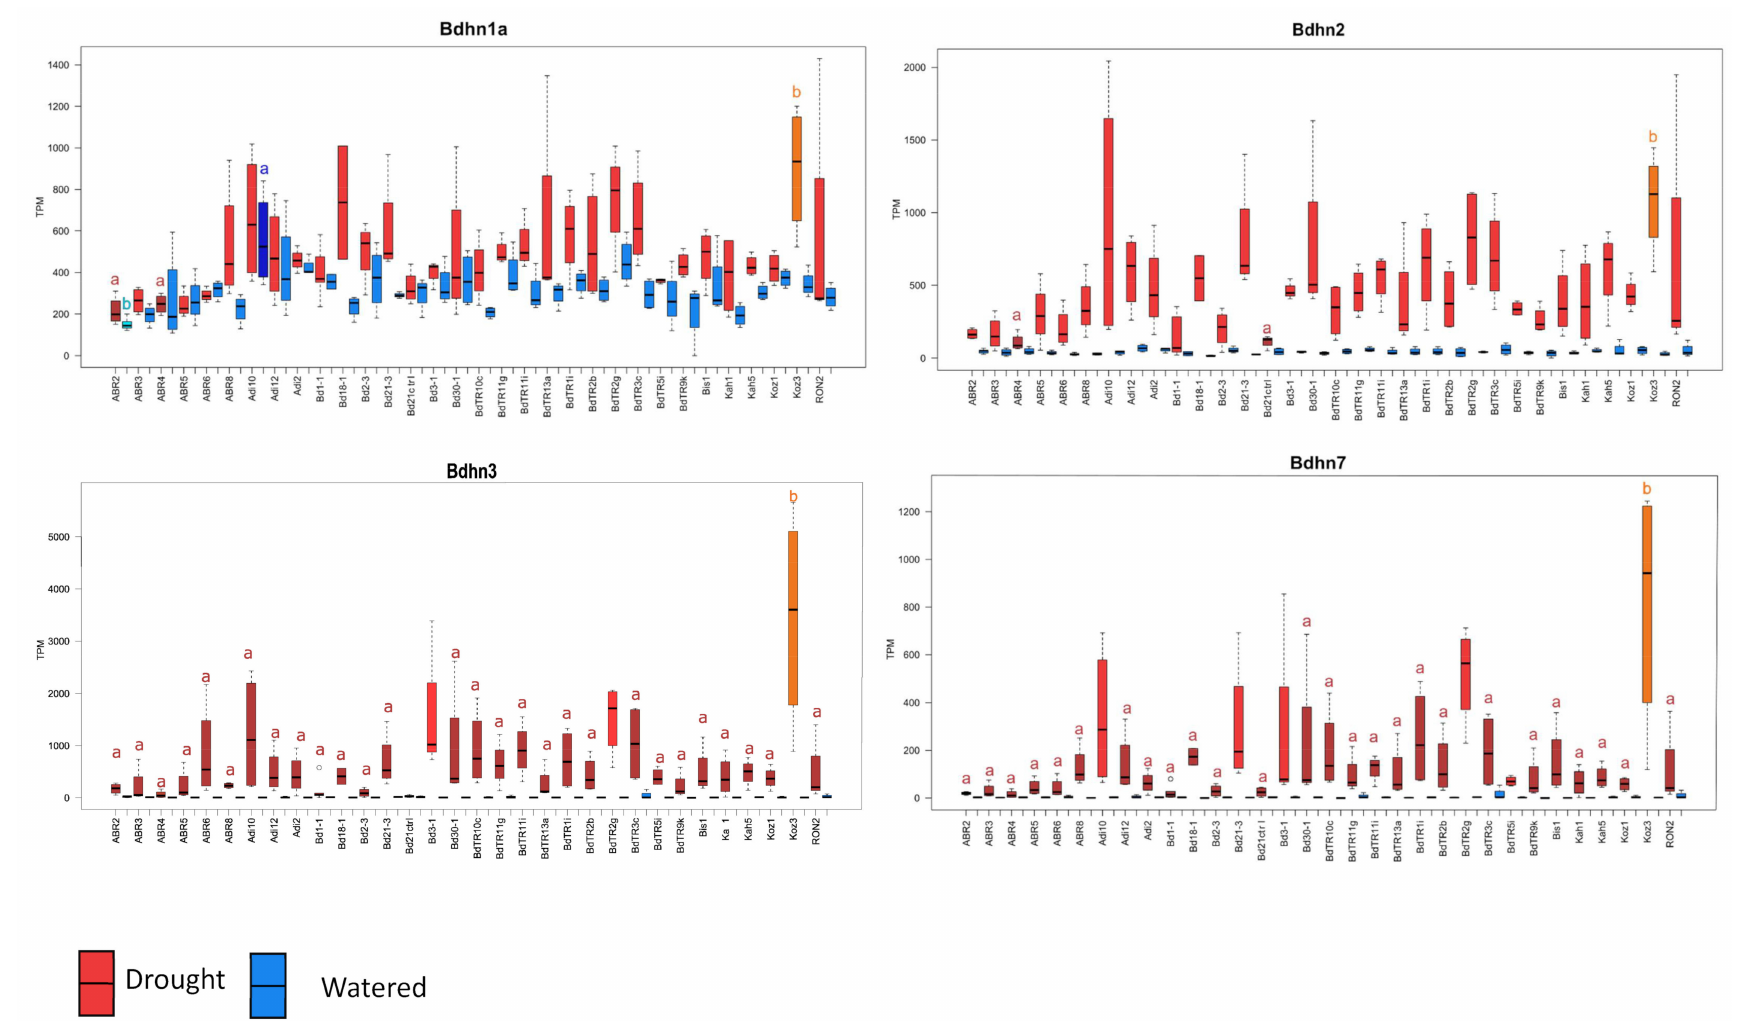
Figure 5. Differentially expressed Bdhn 1a, Bdhn 2, Bdhn 3, and Bdhn 7 dehydrin genes (transcript per million, TPM) in 32 ecotypes of B. distachyon under drought (D, red) vs. watered (W, blue) conditions. Different letters in the boxplots indicate significant group differences (Tukey HSD tests) (see also Supplementary Figure